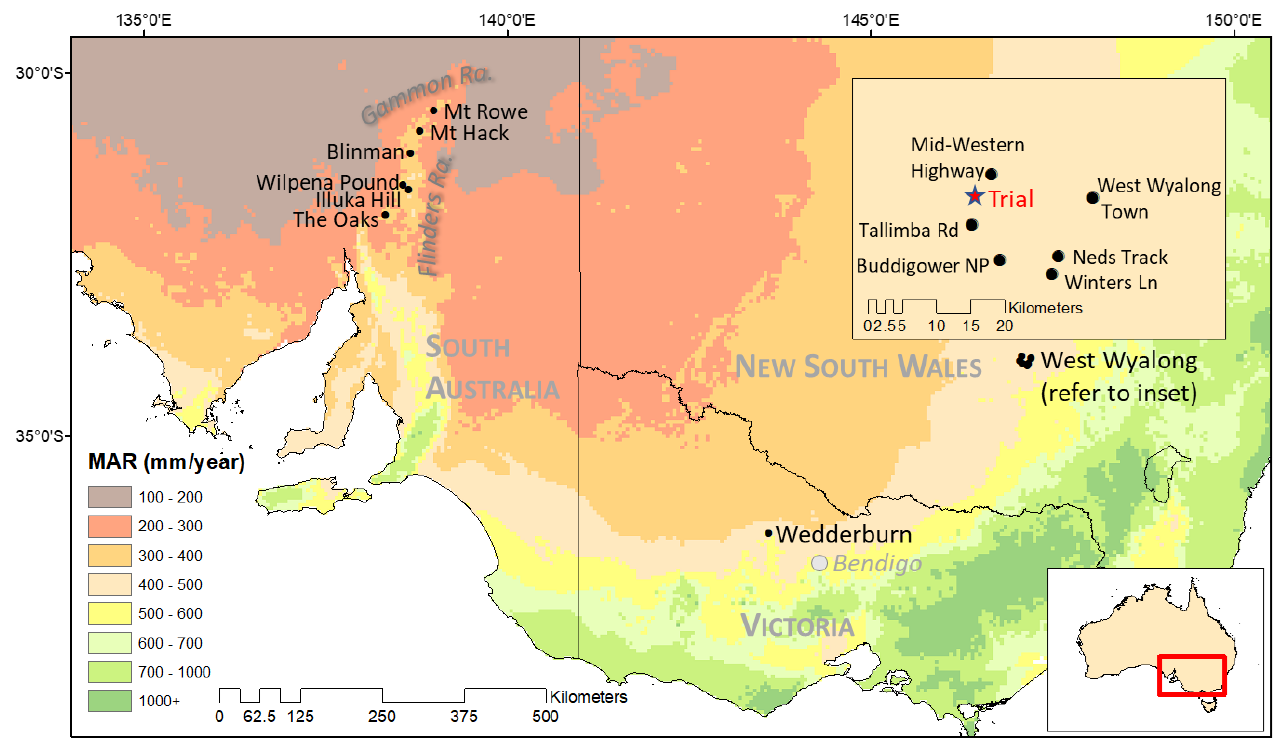
Figure 1. Locations of the trial near West Wyalong, NSW; provenances included in the trial from NSW, Vic and SA, and mean annual rainfall (MAR) distribution.